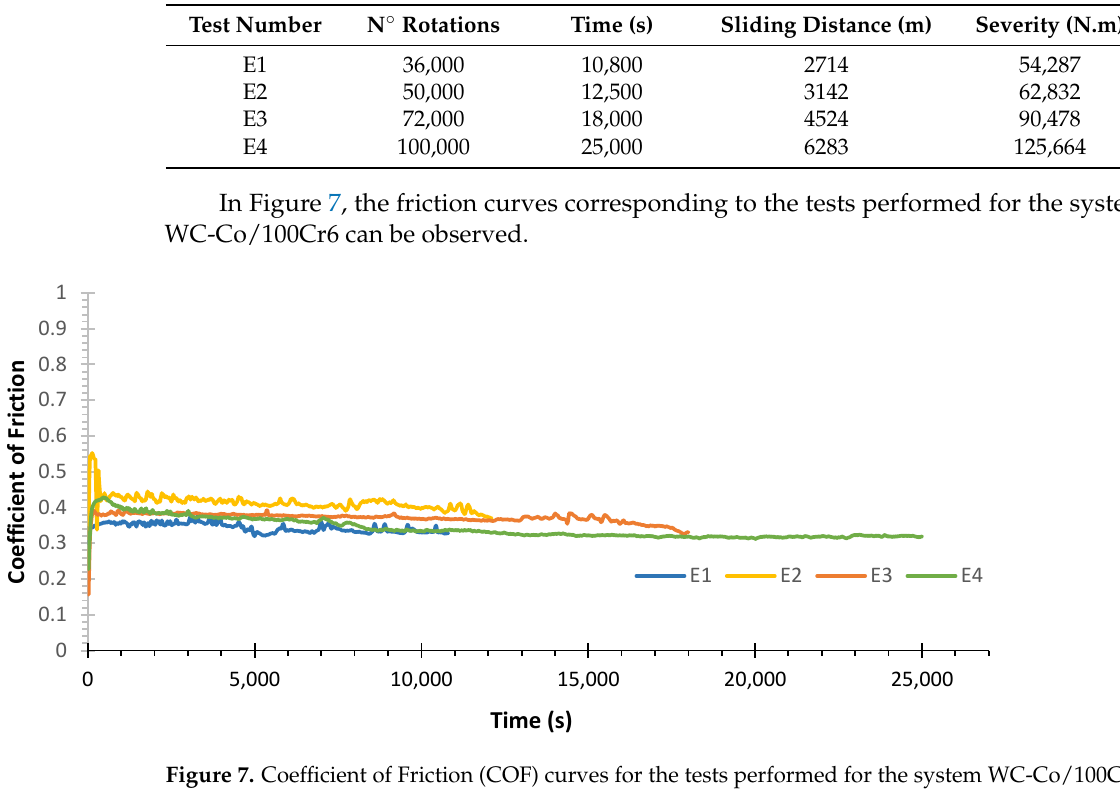
Table 4. Conditions for the experimental tests corresponding to system WC-Co/100Cr6 (applied load corresponding to 20 N).